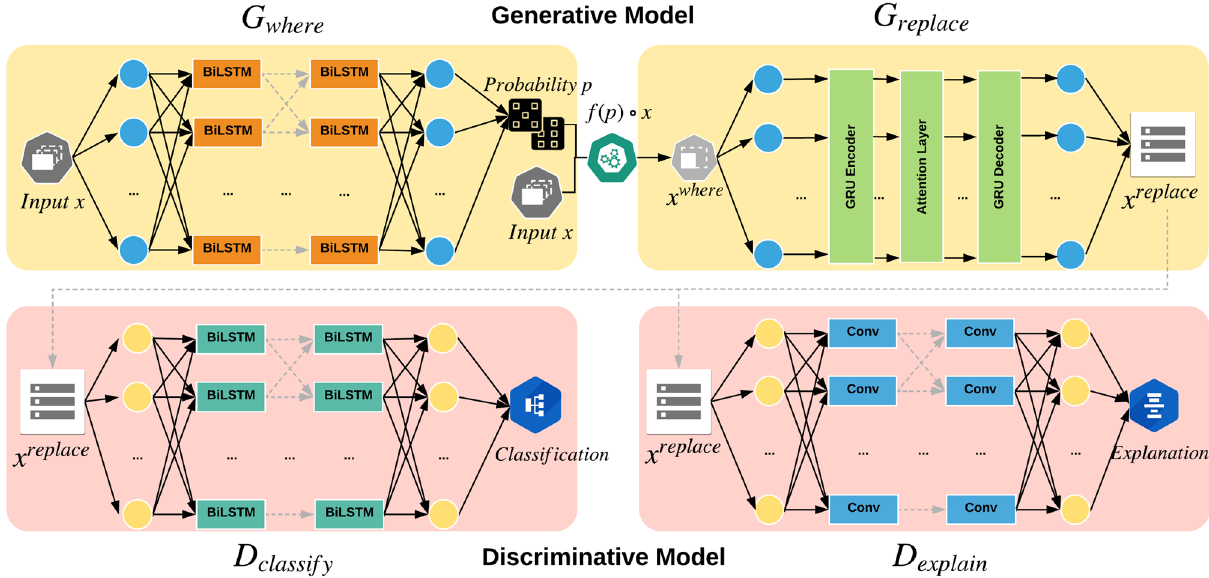
Figure 2. Our proposed framework. The generative model (shown on the left hand side) consists of two generators G where and G replace . The discriminative model (shown on the right hand side) consists of two discriminators, namely D explain for explainability and D classify for